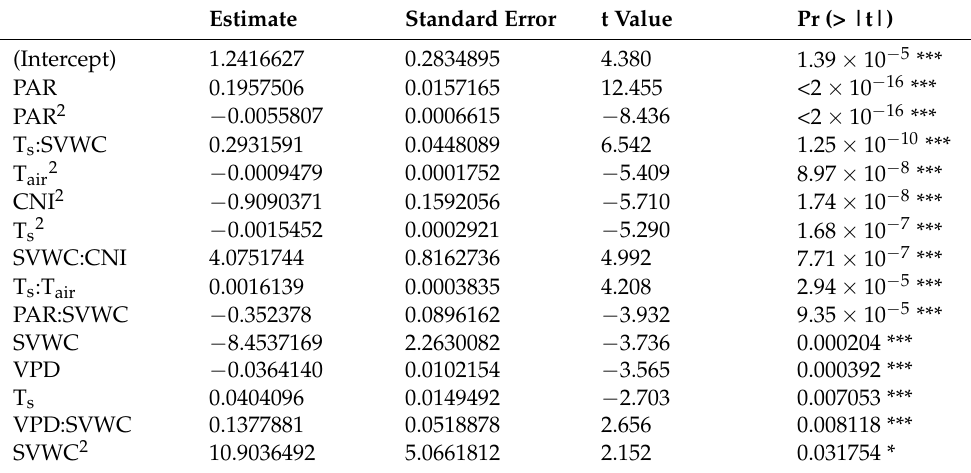
Table A4. Results of the stepwise multi-linear regression model on the significant environmental variables that influenced the normalized gross primary productivity (GPP norm ) at the dry spruce forest site in Rájec (CZ-RAJ). CNI: clearness index; PAR: photosynthetic available radiation; T air : air temperature; T s : soil temperature; SVWC: the soil volumetric water content; and VPD: vapour pressure